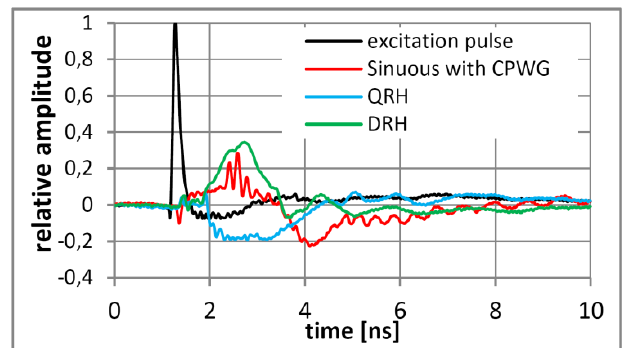
Figure 11. A comparison of the impulse response of our sinuous antenna with CPWG and the available commercial antennas in the time domain.